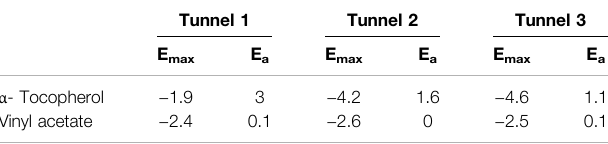
TABLE 3 | Information on the energies corresponding to the input substrates in the tunnels with the highest probability in CALB.